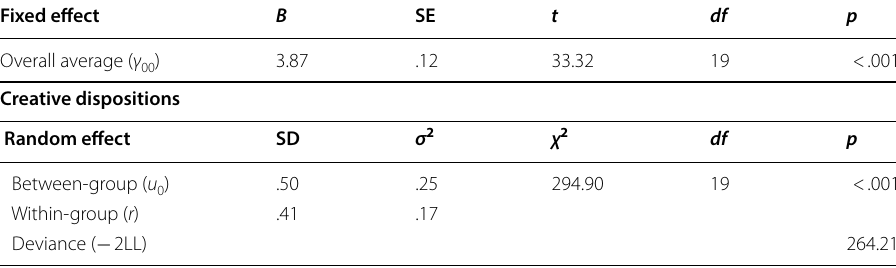
Table 4 The results of the unconditional model of children’s creative